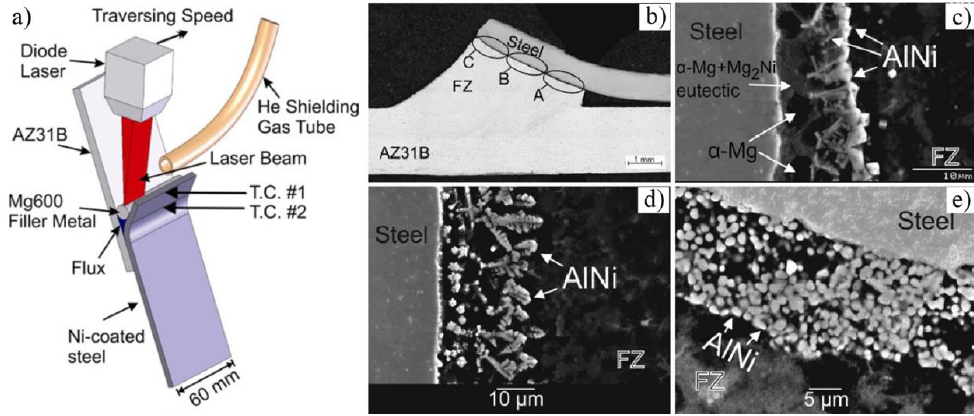
Figure 11. Laser welding of Mg/steel with Ni coating [43] ( a ) schematic diagram of laser bonding of AZ31 Mg and Ni electro-plated steel; ( b ) cross section of joint; ( c – e ) the microstructure of the laser-brazed specimen in A, B, C positions near the interface.